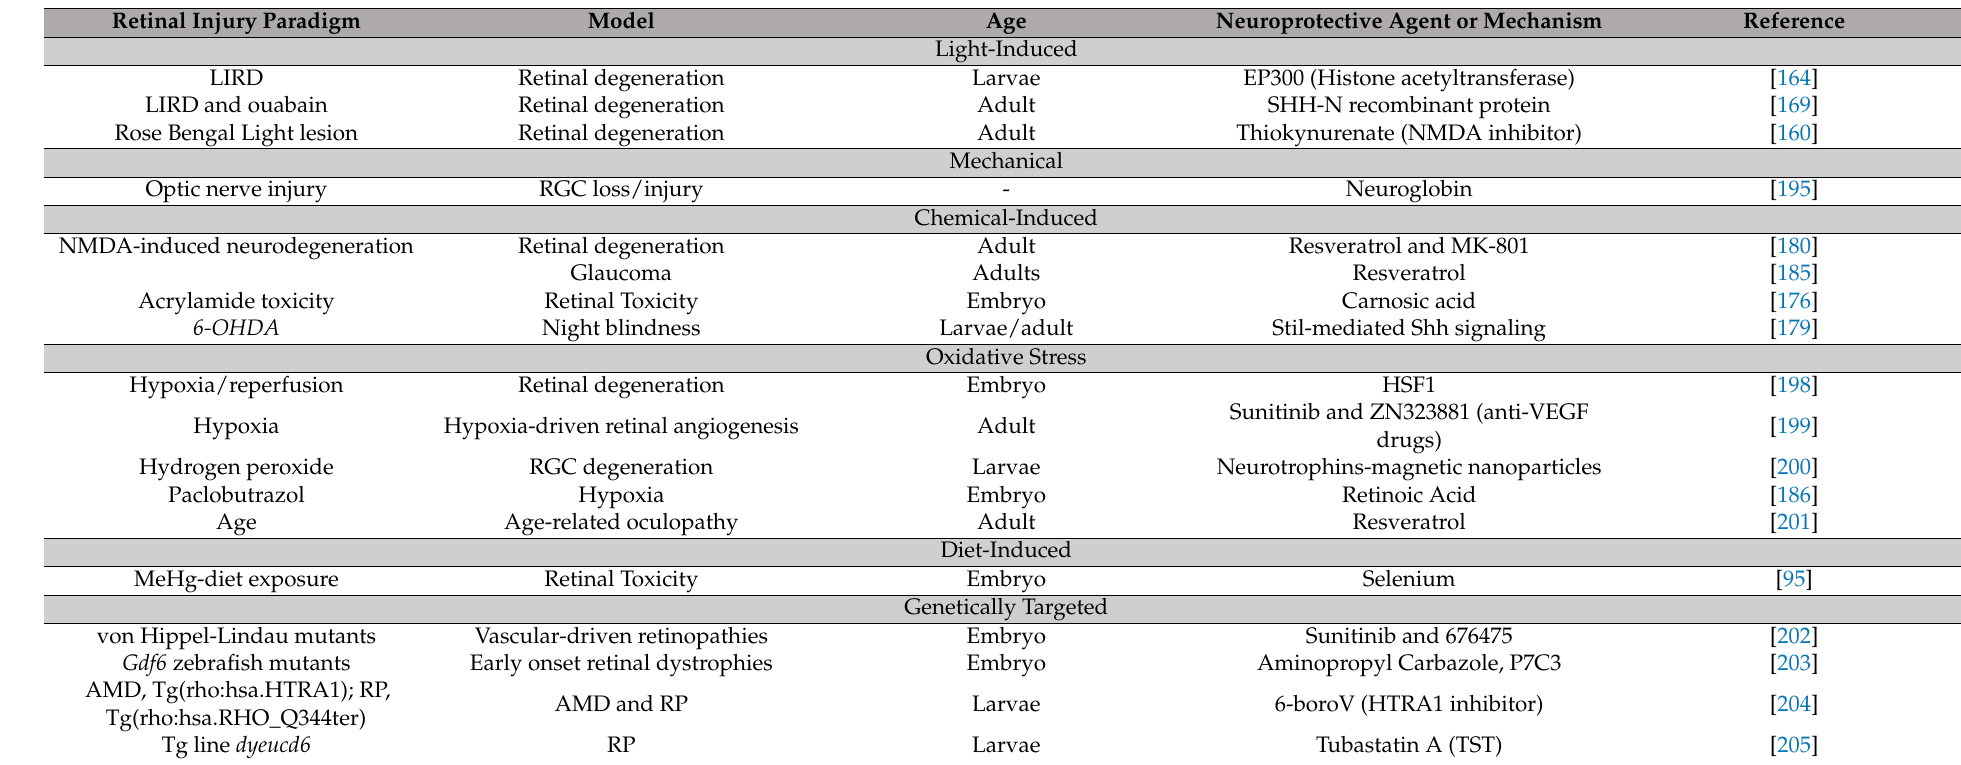
Table 1. Summary of retinal neuroprotection studies that use zebrafish retinal injury